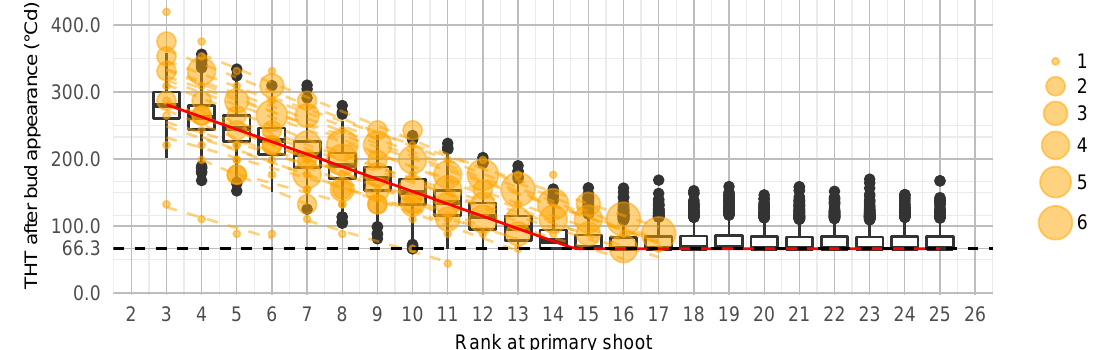
Figure 7. Data (orange) and model (red) to describe lateral bud break as thermal time (THT) after primary bud evolution. Box plots are results of sampling ( n = 1000) from a Gaussian normal distribution around the mean ( σ THT,BB,2 = 27.98003) after correcting for minimal THT BB,2,min = 66.2676229 ◦